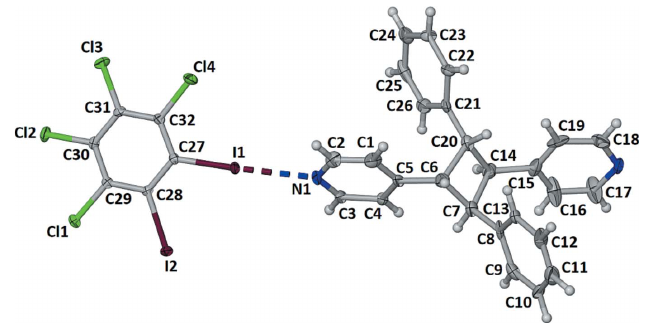
Figure 2 X-ray crystal structure of ( 1,2-C 6 I 2 Cl 4 ) (cid:2) ( ht -PP ) illustrating the zigzag network held together by I (cid:2)(cid:2)(cid:2) N halogen bonds. The determined error in all measured angles is 0.1 (cid:3) . Halogen bonds are represented by yellow dashed